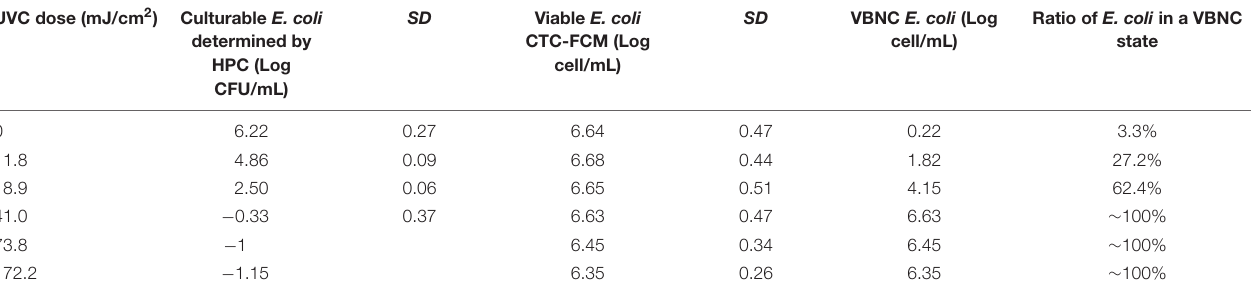
SD is the standard deviation of results from three independent experiments.